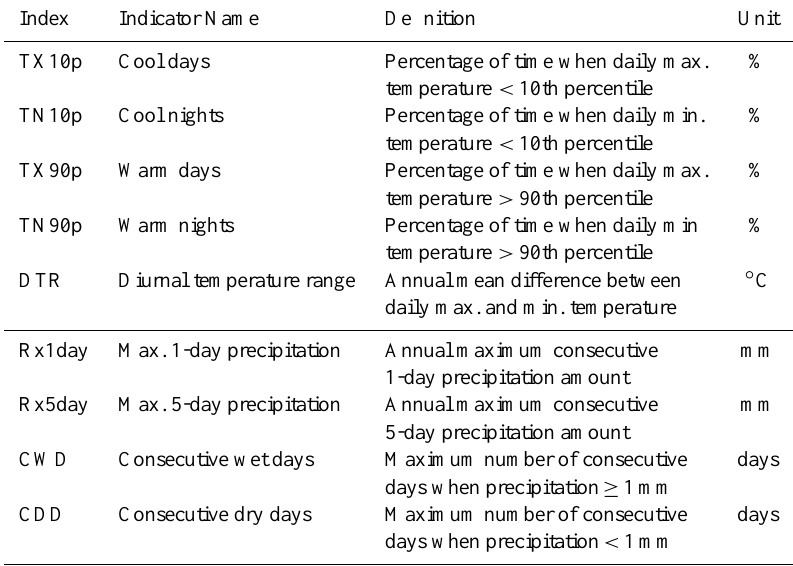
Table 1. Extreme temperature and precipitation indices used in this study. The first four indices measure frequency of temperature extremes, DTR measures the amplitude between the coldest and hottest daily temperatures and the last four indices measure rainfall extremes (three wet extremes, last one dry extreme). Percentiles are calculated over the 1961–1990 reference period.